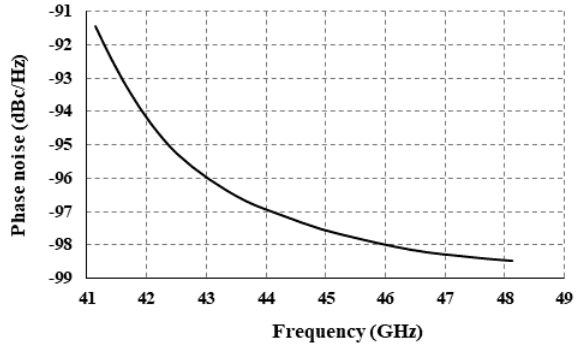
Electronics 2019 , 8 , x FOR PEER REVIEW Figure 10. The simulated output power of the VCO at 48.11 GHz. Figure 10. The simulated output power of the VCO at 48.11 GHz. Figure 10. The simulated output power of the VCO at 48.11 GHz.